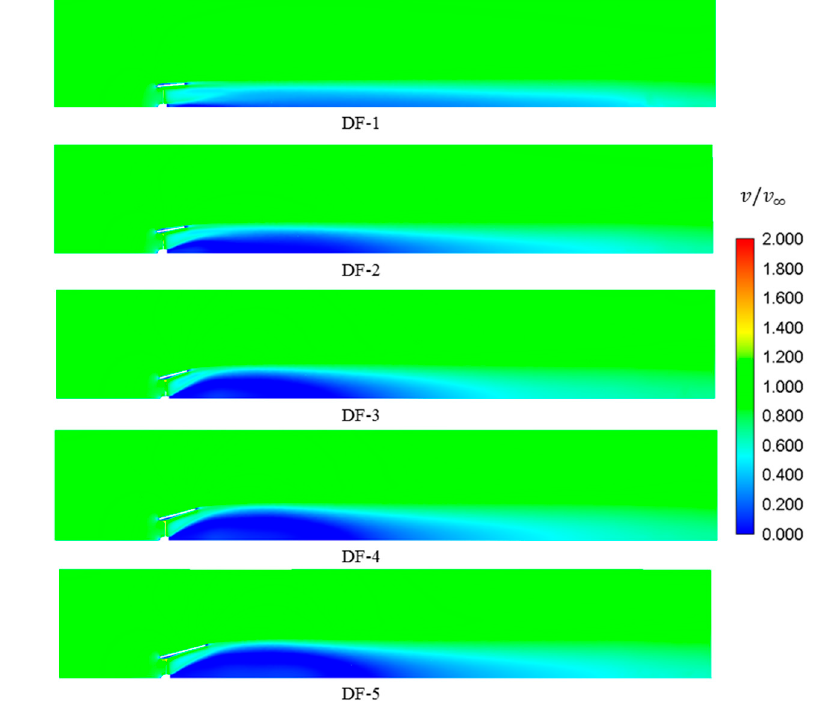
Figure 13. Normalized velocity in longitudinal plane at TSR = 5, turbine design DF.